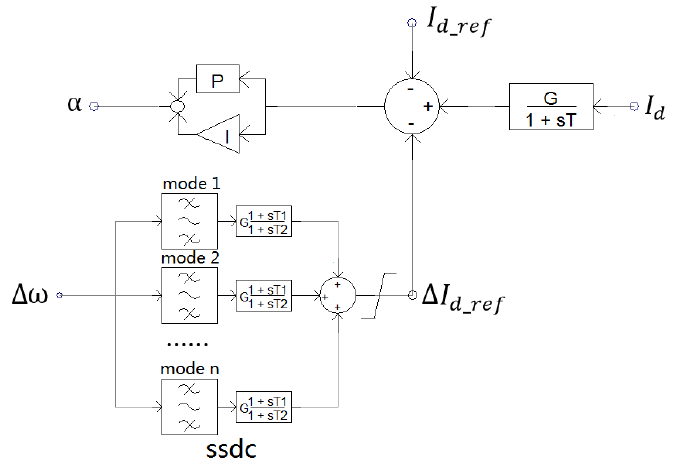
Figure 2. Topology of SSDC with multi-modal structure based on the phase-compensation